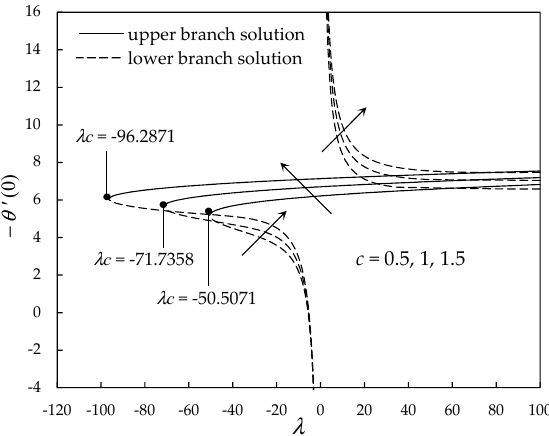
Figure 13. Variation of the reduced local Nusselt number −𝜃′(0) with the mixed convection parameter 𝜆 for various values of c (stretching sheet) when 𝜙 = 0.01, Nr = 0.1, K = 0.1 and s = 1 for Cu-water nanofluid.